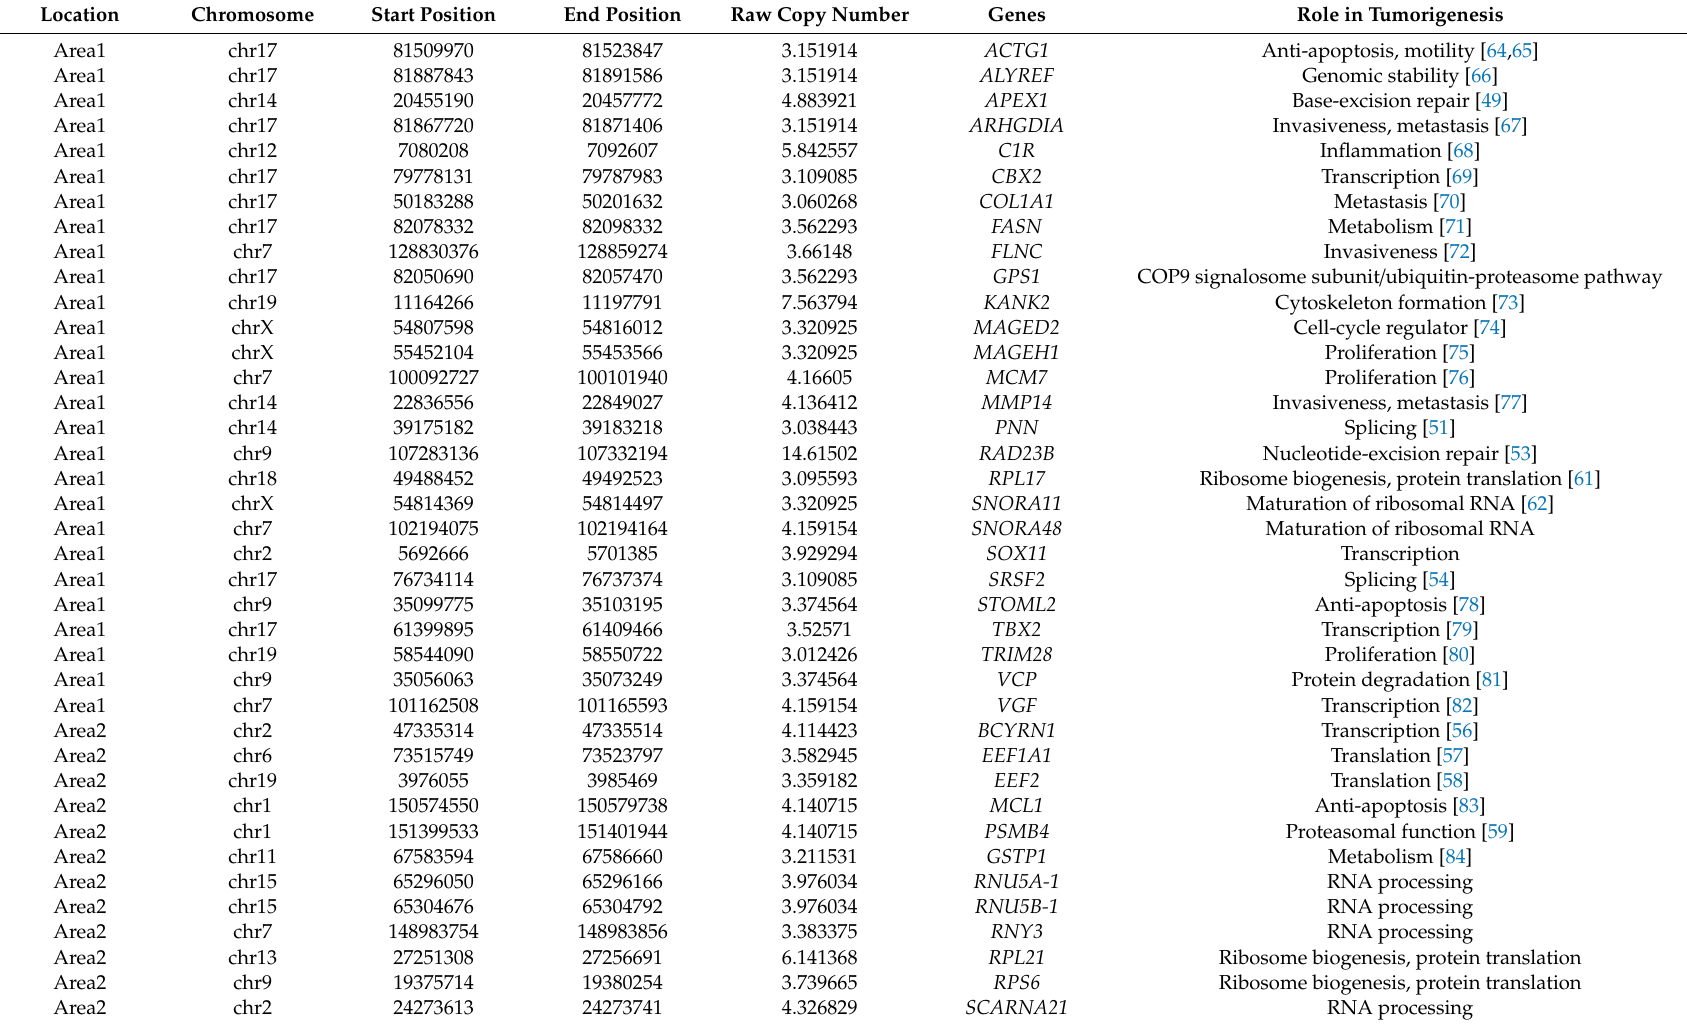
Table 4. Di ff erentially Expressed Gene Pathway Analysis. These genes were located in copy number aberrant regions defined as copy number more than 3 or lower 1 and also demonstrated di ff erential expression by RNA seq. Di ff erent pathways are implicated in the distinct